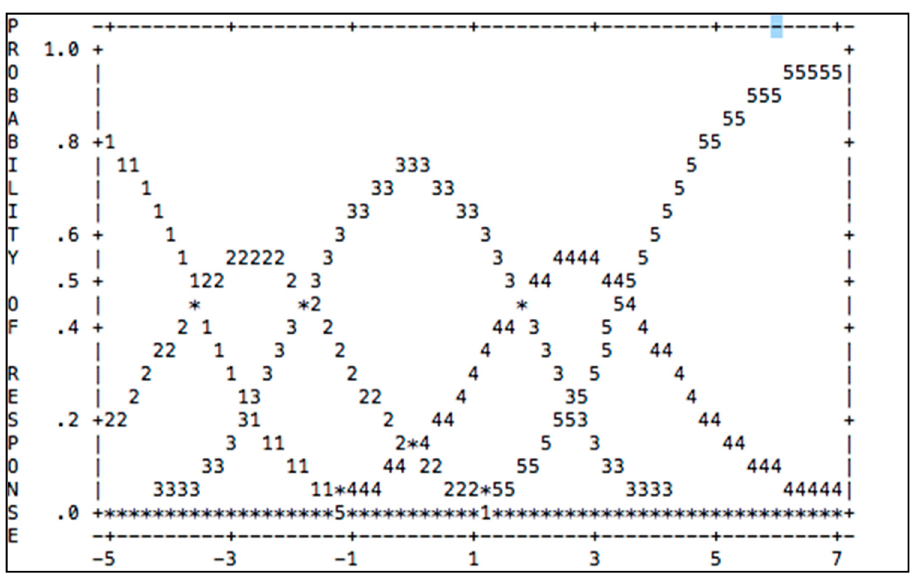
Figure 1. Summary of the category structure on a scale gradation .